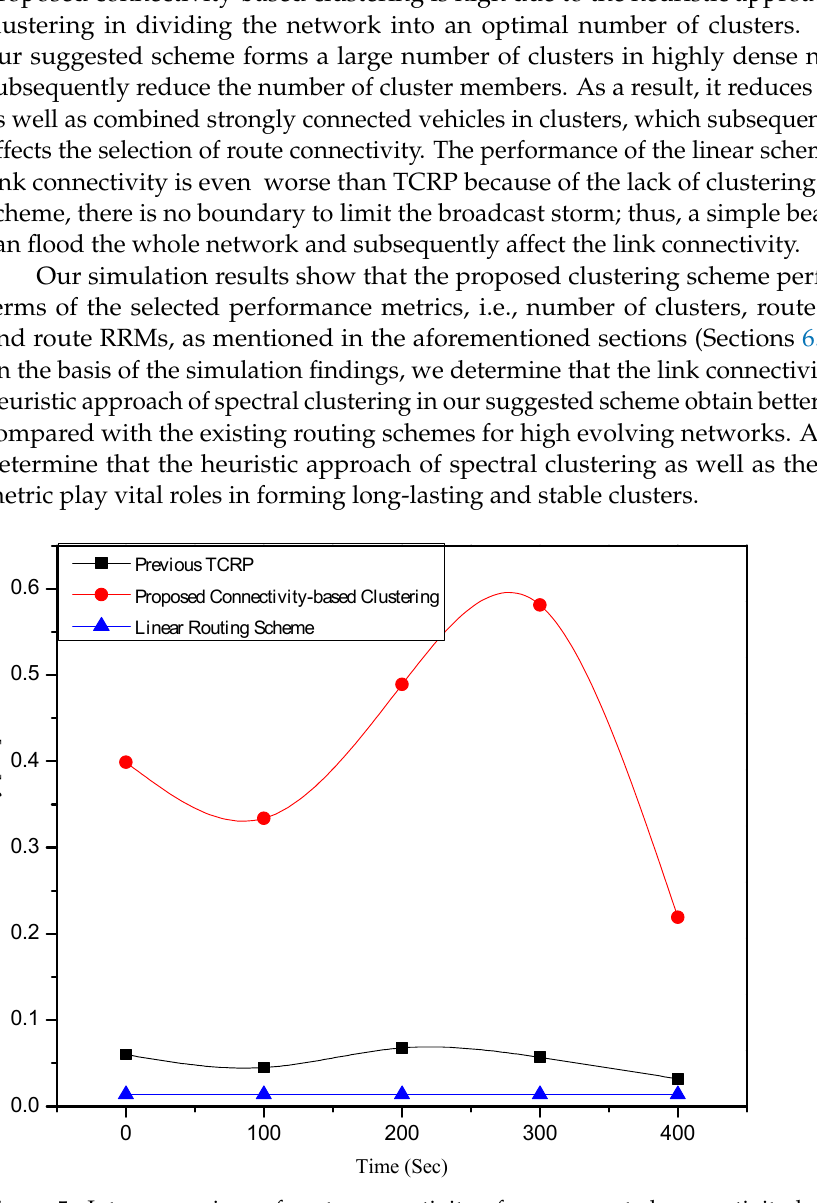
Figure 5. Intercomparison of route connectivity of our suggested connectivity-based clustering scheme with TCRP [1] and linear routing